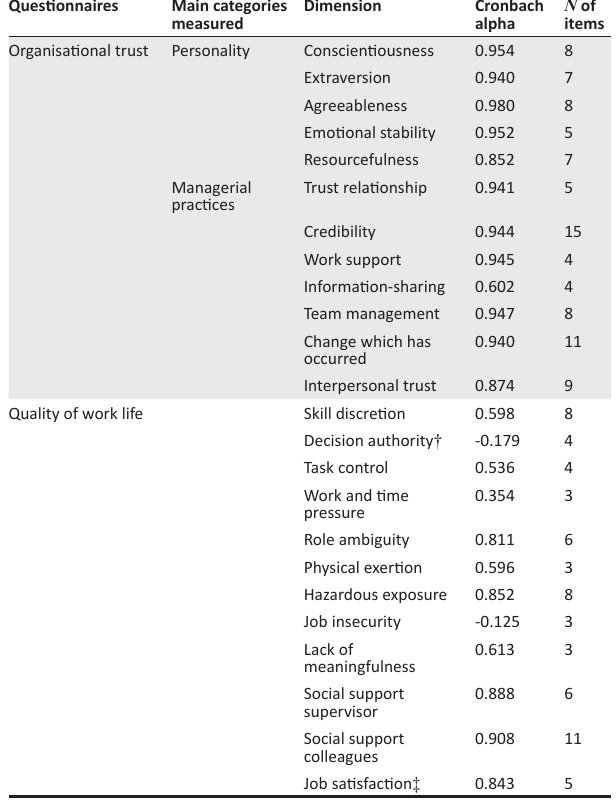
TABLE 1: Results of reliability analysis.